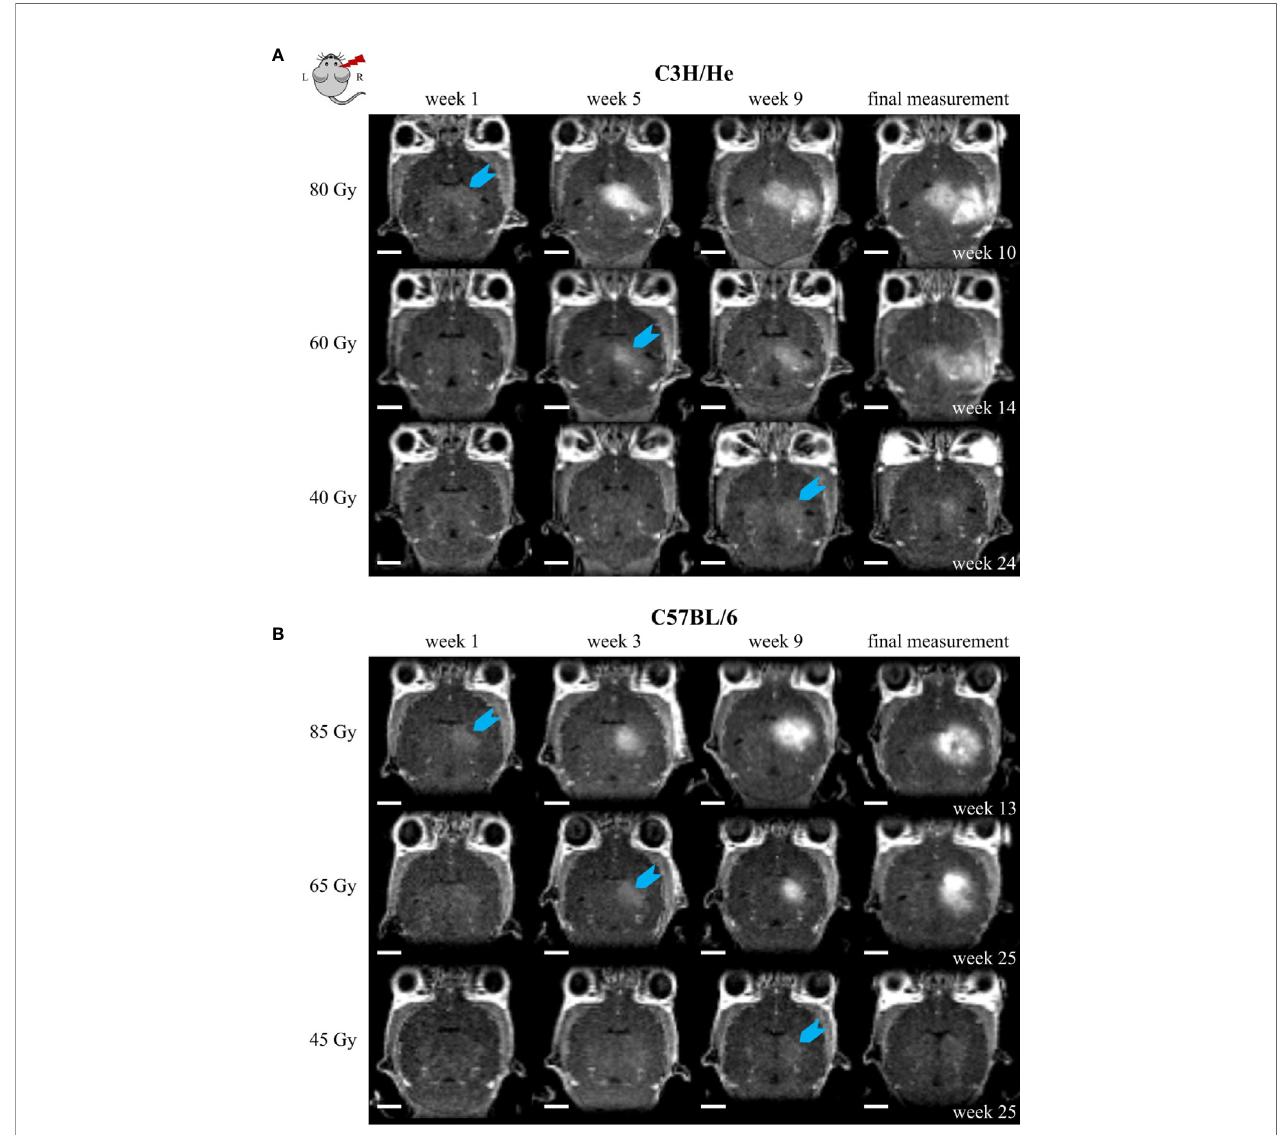
FIGURE 5 | Exemplary CE T1w MR images of (A) C3H/He and (B) C57BL/6 for one selected mouse per dose group. The time points were chosen to re fl ect signal onset (blue arrow) in the different treatment groups. CE appeared sooner for higher doses. However, the progression pattern in the mouse strains matched and if the stopping criterion, i.e. health deterioration, was reached, affected volumes corresponded also between different doses. Scale bars 2